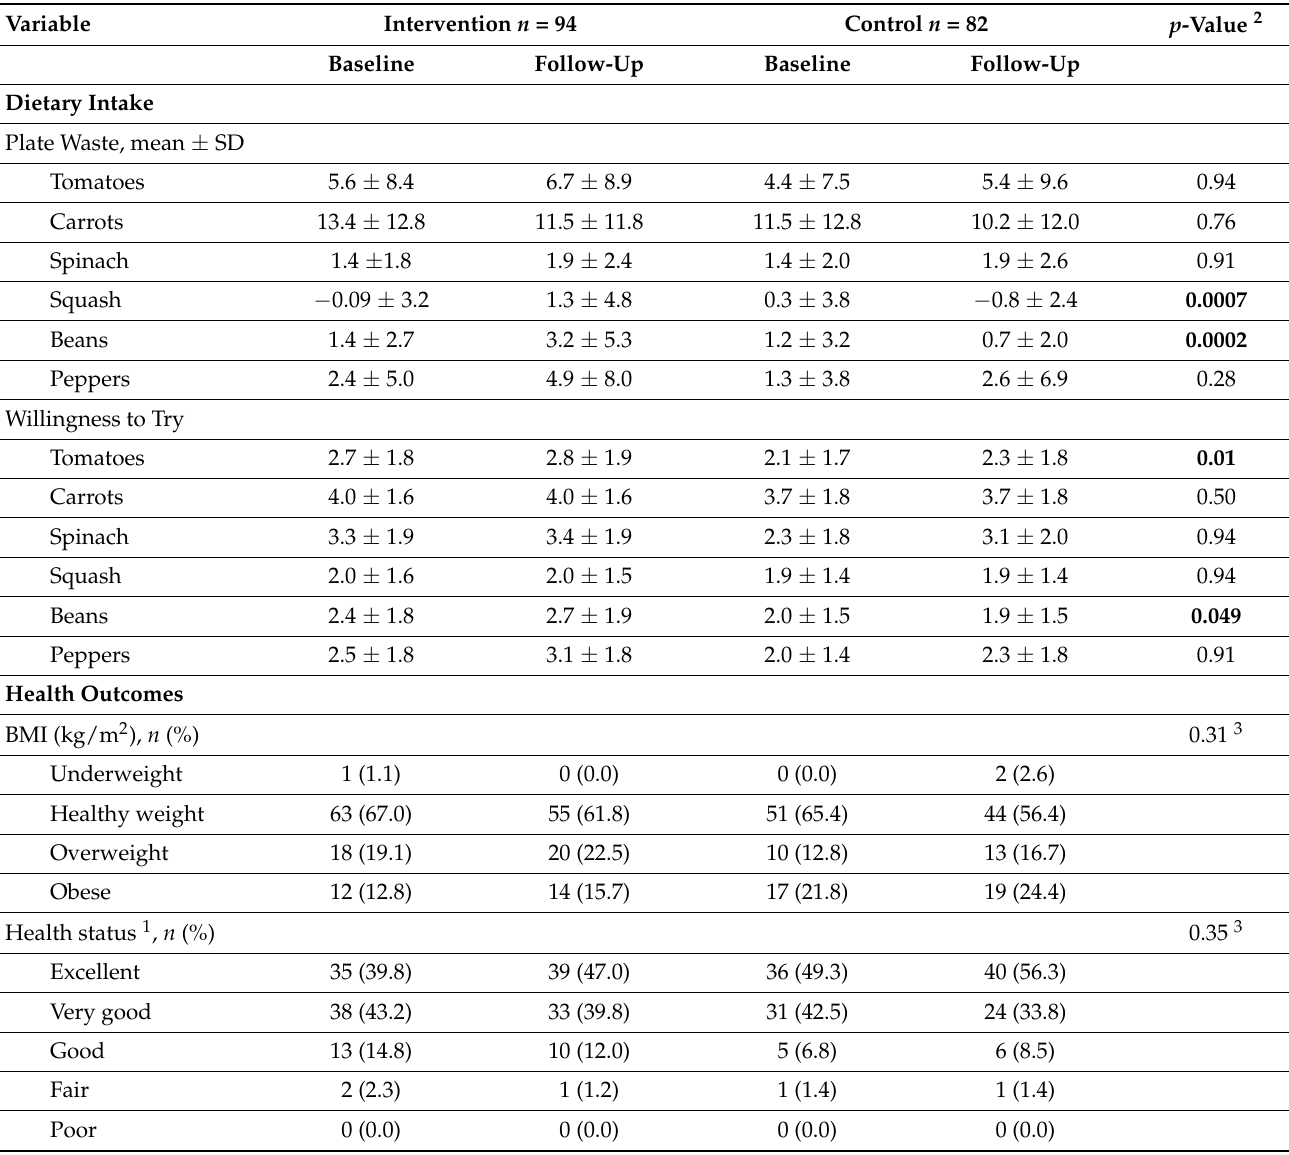
Table 2. Differences in baseline and follow-up measurements of outcomes for children in the FRESH